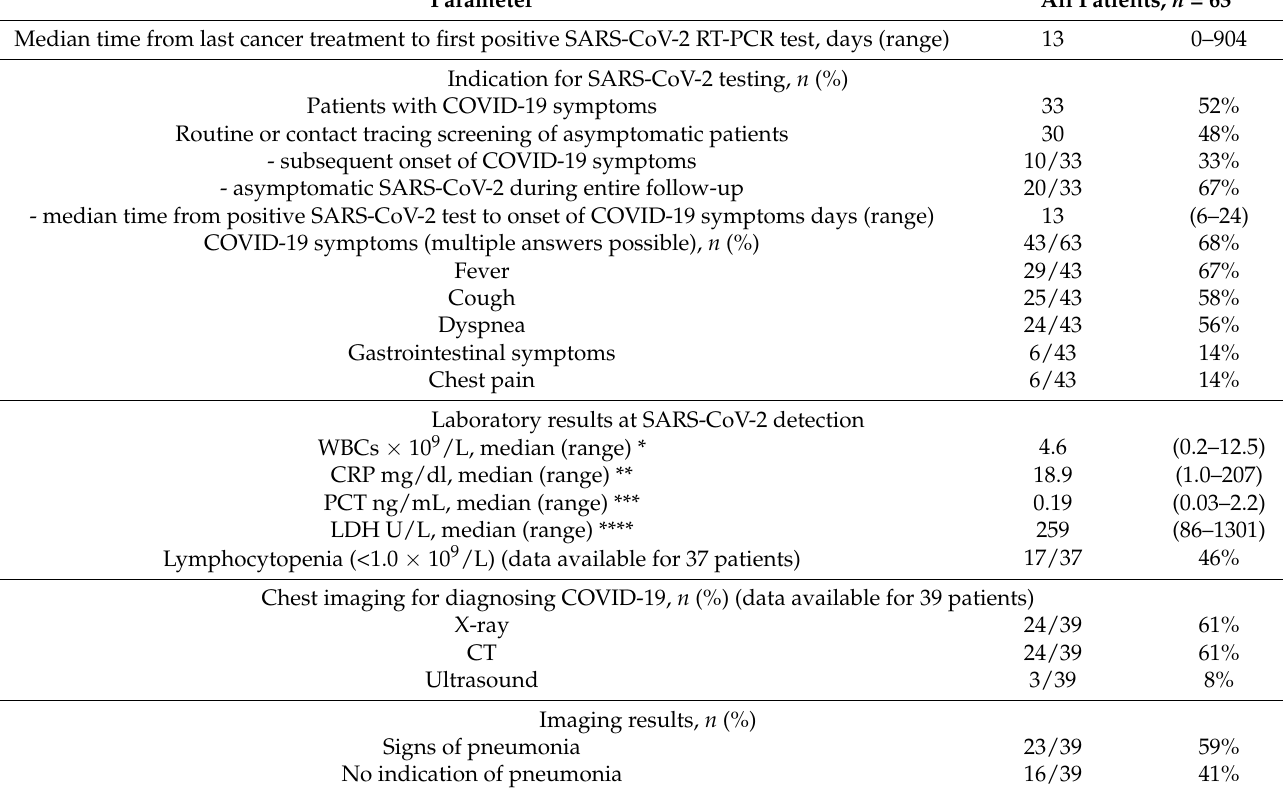
Table 2. Laboratory, imaging and clinical findings in 63 cancer patients with SARS-CoV-2. RT-PCR, real-time reverse transcriptase polymerase chain reaction; n , number; CT, computed tomography; WBCs, white blood cells; CRP, c-reactive protein; PCT, procalcitonin; LDH, lactate dehydrogenase; pts, patients. Parameter All Patients, n = 63 Median time from last cancer treatment to first positive SARS-CoV-2 RT-PCR test, days (range)